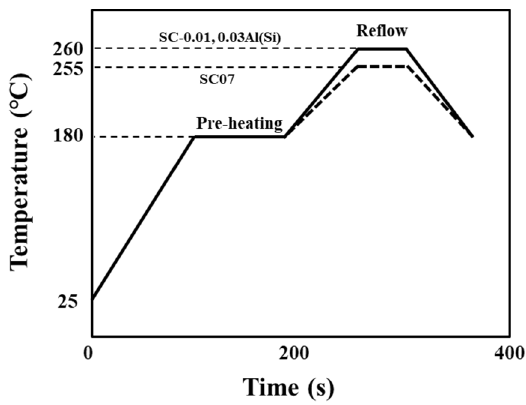
Figure 2. Schematic diagram of the solder ball coupon fabrication.